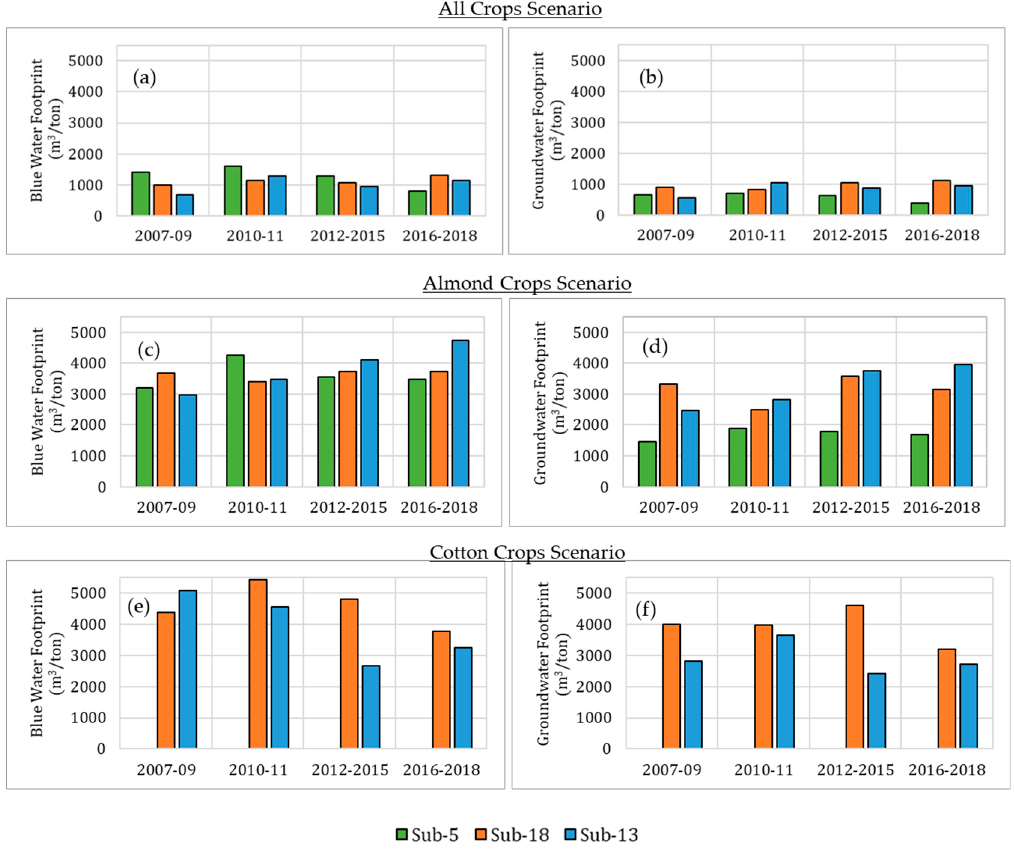
Figure 8. Total Blue Water Footprints ( left column) and Groundwater Footprints ( right column) in Figure 8 . Total Blue Water Footprints (left column) and Groundwater Footprints (right column) in three study regions for all crops, almond and three study regions for all crops, almond and cotton.